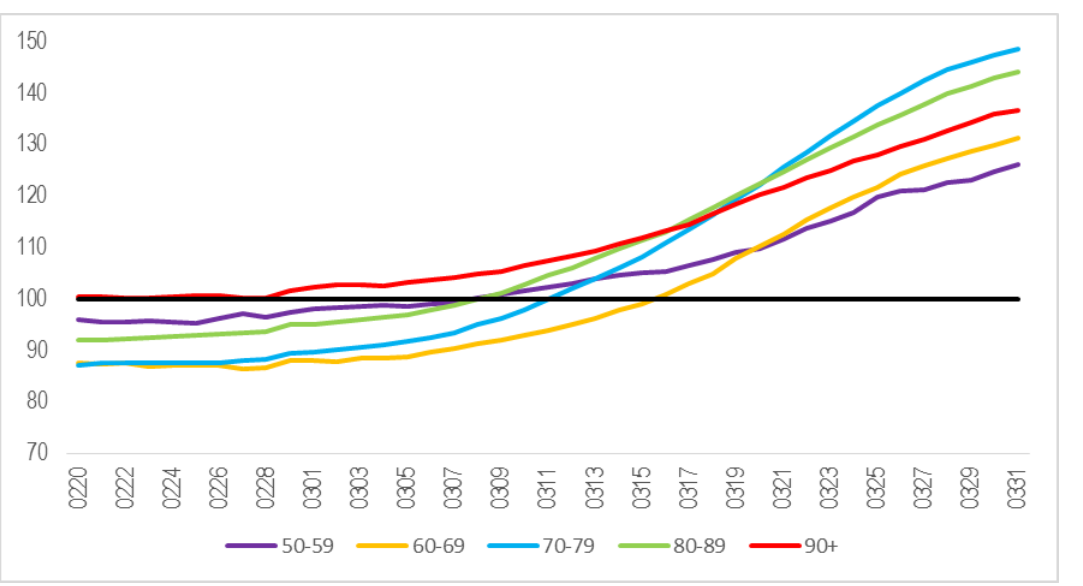
Figura 3. Decessi maschili cumulati a partire dal primo gennaio per classe di età. Per 100 decessi della stessa classe di età in base alla media 2015-2019. Province con alto livello di diffusione Covid-19. Periodo: